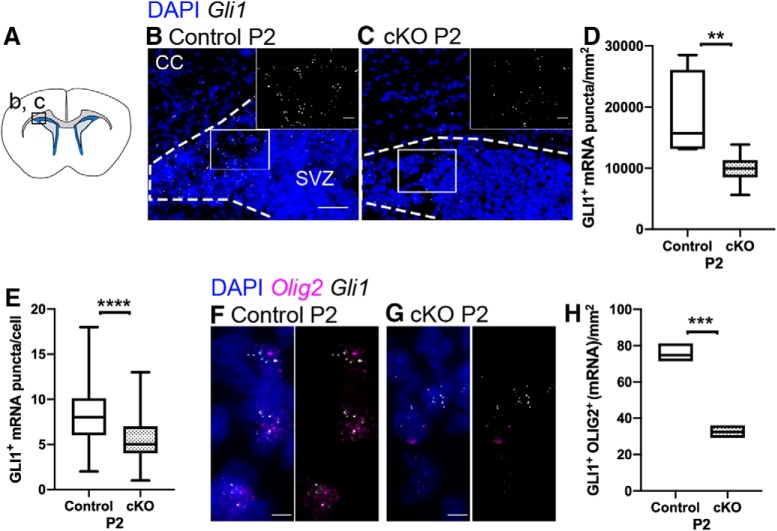
Gli1 expression is reduced in the SVZ in Raldh2 cKO mice. A, Coronal section illustrating the region imaged in B, C. B, C, In controls and cKO mice, Gli1 mRNA puncta (white) are found in the SVZ (delineated by dotted lines) and the transition from the SVZ into the CC (area flanking the top dotted line in B, C). D, The total number of Gli1 puncta in the SVZ and its border with the CC is reduced in cKO at P2 relative to controls. E, The number of Gli1 mRNA puncta per cell is reduced in cKO mice. F, G, Gli1+Olig2+-co-labeled cells (white and magenta) cells are found at the border between the SVZ and CC in controls and cKO. H, The number of Gli1+Olig2+ cells is reduced in cKO mice. CC, corpus callosum; SVZ, subventricular zone; LV, lateral ventricle; cKO, conditional knock-out. Scale bars: 50 μm (B, C) and 5 μm (F, G). Box and whisker plot, box: 25th and 75th percentile, whiskers: minimum to maximum value, line at median. Floating bar plot, box: minimum to maximum value, line at median. **p < 0.01, ***p < 0.001, ****p < 0.0001.